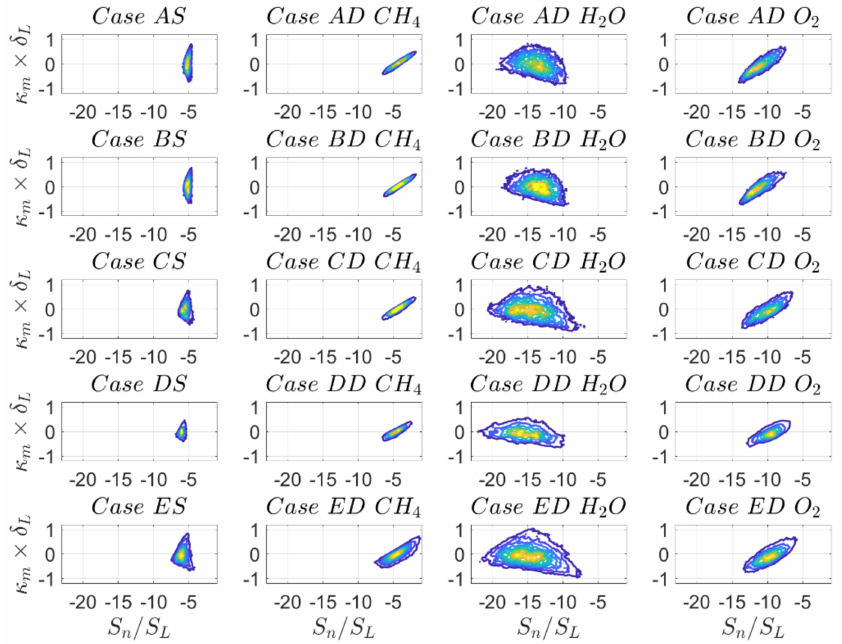
Figure 16. Joint PDF of normalised normal diffusion component of displacement speed S n / S L and normalised mean curvature κ m × δ L on c = 0.8 progress-variable isosurface for top to bottom cases A–E for (1st column) SC and (2nd to 4th column) DC simulations for reaction progress variable based on CH 4 , H 2 O,O 2 mass